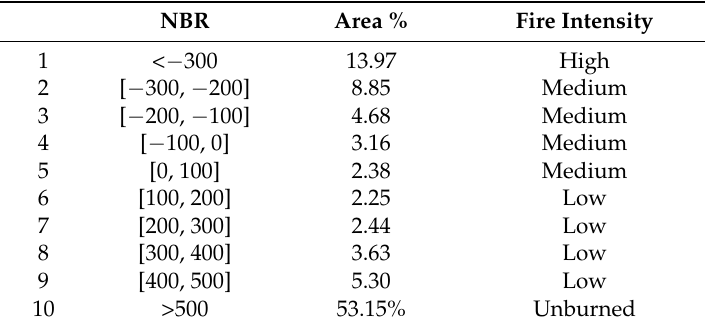
Table 3. The NBR ranks and the grouped fire intensities.